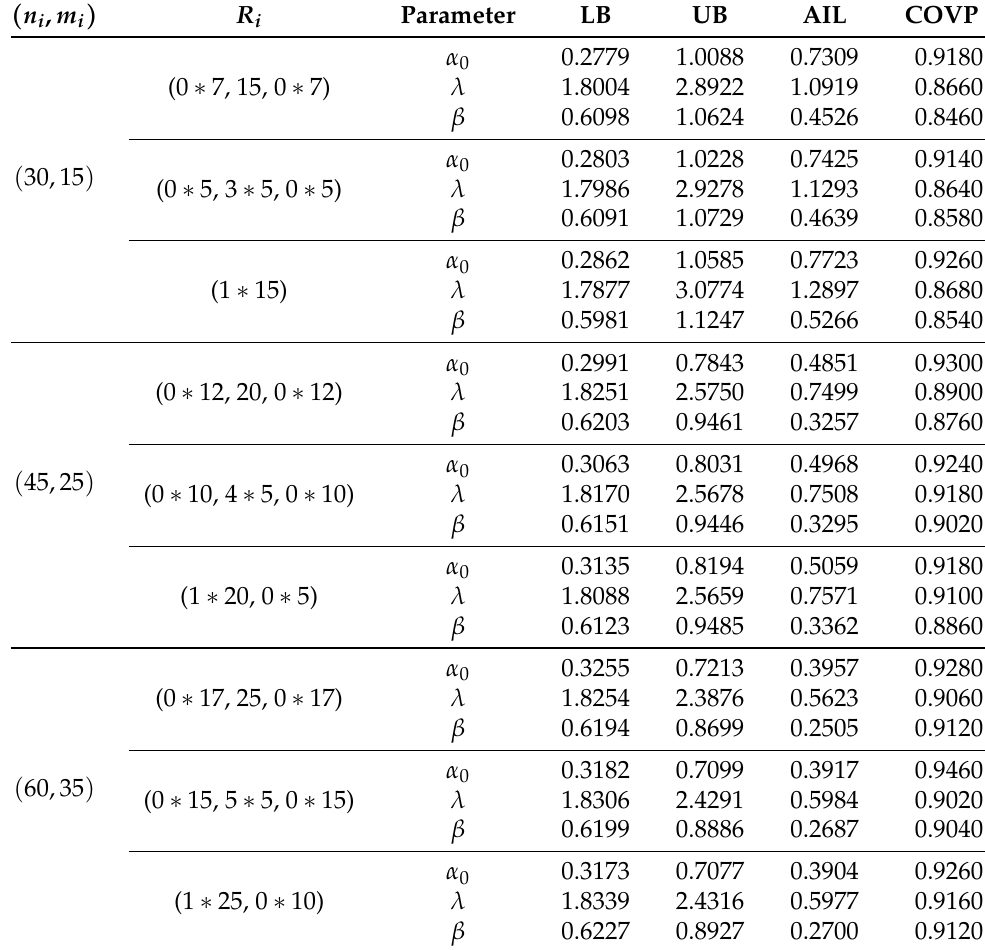
Table 6. The lower bounds (LB), upper bounds (UB), average interval lengths (AIL) and coverage probabilities (COVP) of the 95% bootstrap-t confidence interval for different sample sizes ( n i , m i ) and different censoring schemes R i .